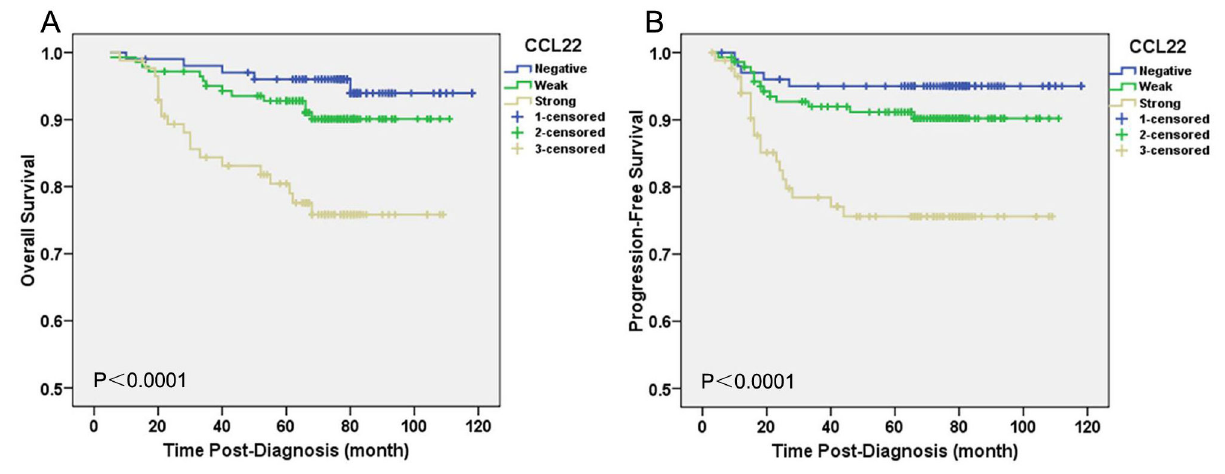
Figure 2. Prognostic significance of CCL22 Expression in BC. Kaplan–Meier curves of overall survival (OS) (A) and progression-free survival (PFS) (B) for CCL22 expression in BC to show the association of CCL22 expression with reduced OS (P<0.0001) and PFS (P<0.0001). P values were calculated by the log-rank test.